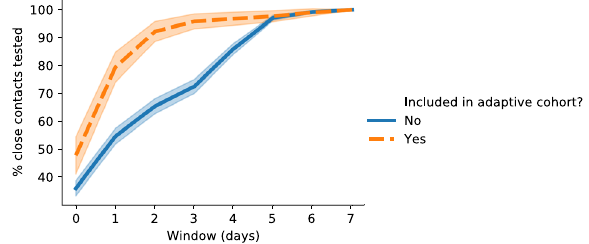
Fig. 3 The distribution of average time to receive a test for students who were exposed to COVID-19 via close contact with another student. Day 0 is the day the exposing student tested positive. Shaded regions indicate 95% con fi dence